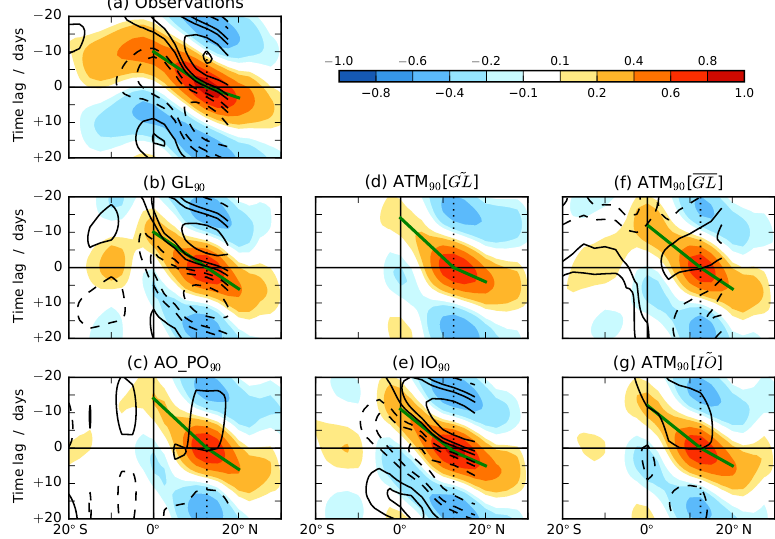
Figure 6. Intraseasonal propagation in the region 70–100 ◦ E, 20 ◦ S–30 ◦ N using 24–70-day bandpass-filtered data, for May to October only, illustrated by lag correlations at each latitude between zonally averaged data and the OLR time series (also filtered) at a base point 85 ◦ E, 12.5 ◦ N. Coloured shading is for zonally averaged OLR. Green lines show propagation from 0 to 12.5 ◦ N and 12.5 to 20 ◦ N. Black contours are for zonally averaged SST, with solid (dashed) contours indicating negative (positive) correlation (remembering that negative OLR anomalies correspond to increased convection) and the contour interval being the same as for the coloured shading. SST is shown up to 17.5 ◦ N only, where half of the longitude domain is occupied by land. The vertical dotted line shows the latitude of the base point. (a) Observations and reanalysis (AVHRR OLR and ERA-Interim SST), (b) GL 90 , (c) AO_PO 90 , (d) ATM 90 [ f GL] (note that SST correlations are too small to appear), (e) IO 90 , (f) ATM 90 [GL], (g) ATM 90 [ e IO].